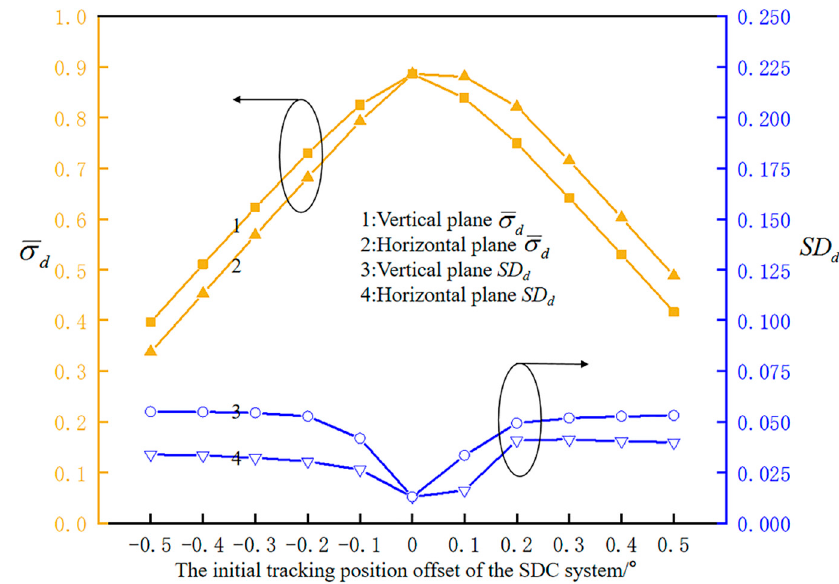
Figure 8. Variation of the daily average effective tracking factor σ d and SD d of an SDC system with initial tracking position offset.